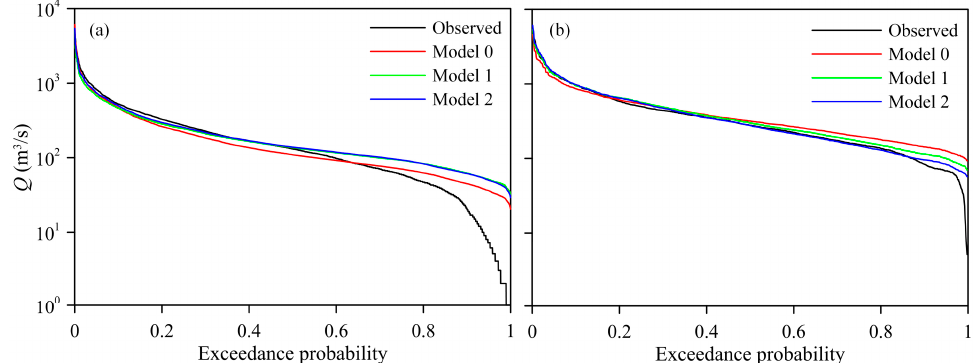
Figure 3. Comparison between the observed and simulated flow-duration curves for the whole period ( a ) and autumn season ( b ) from model zero, one and two.